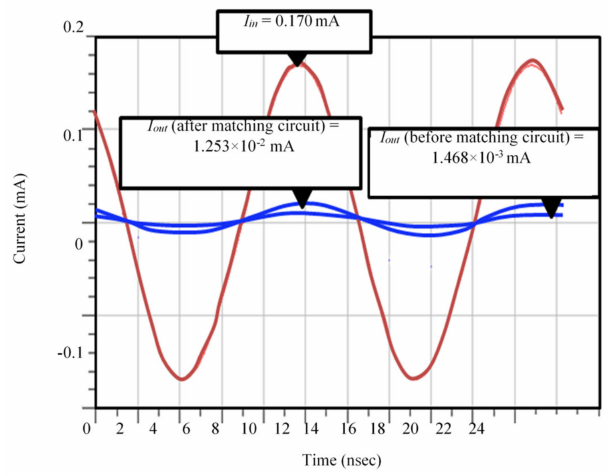
Figure 13. Current results of Cockcroft-Walton voltage multiplier circuit.